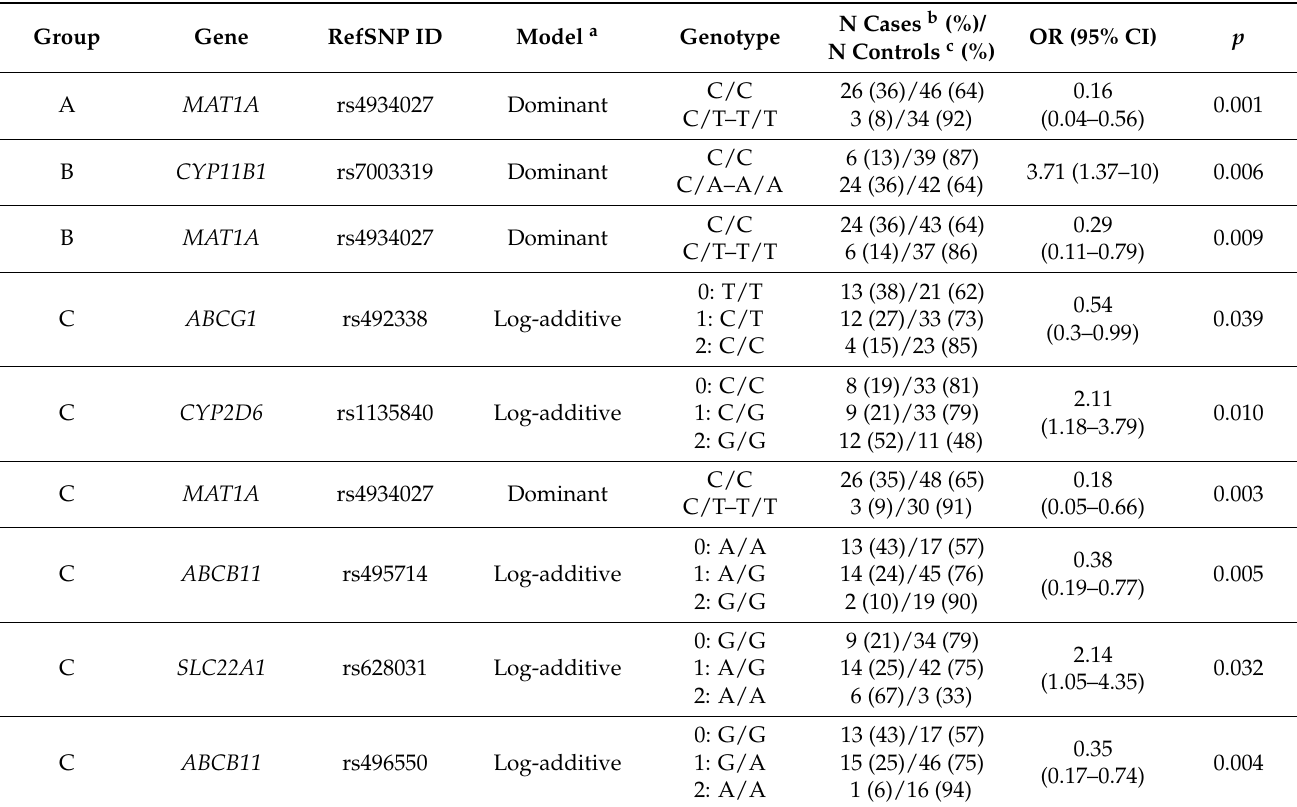
Table 3. gSNVs significantly associated ( p < 0.05) with MMR achievement with imatinib first-line treatment in the cross-validation analysis. Groups A, B, C, D and E correspond to one of the five analyses performed for this